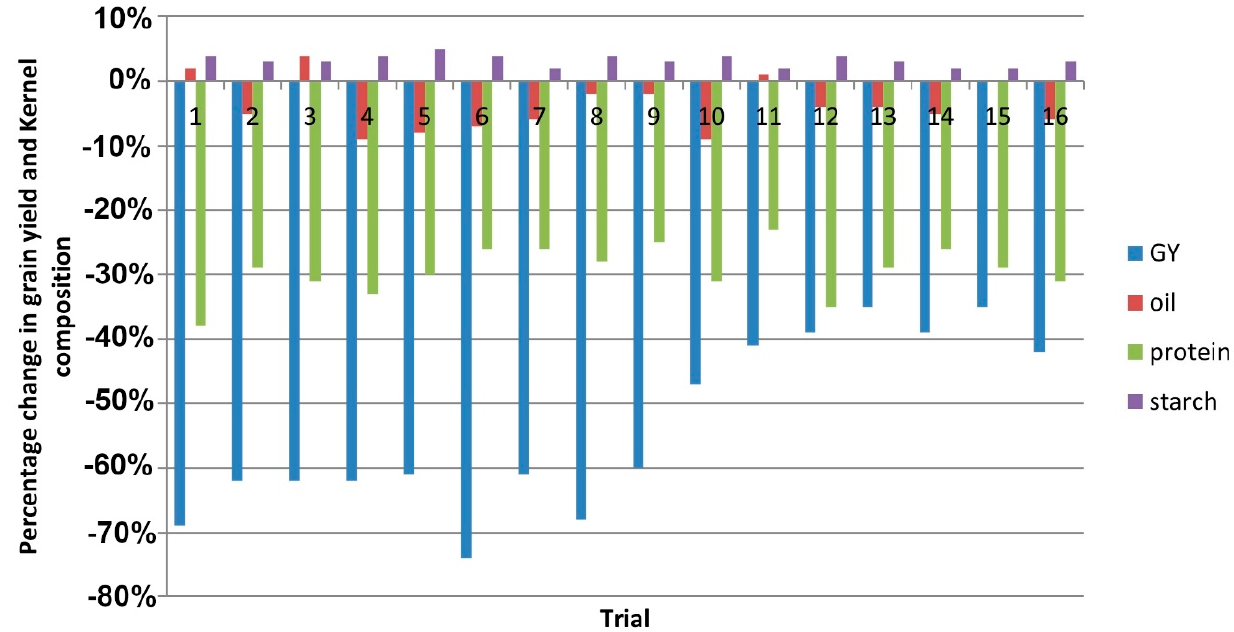
Figure 1. Percentage increase or decrease in grain yield, oil content, protein content and starch content under low-N management compared to their performance under optimum soil nitrogen condi- tion.